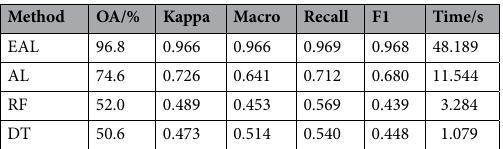
Table 5. Comparison of classification results with the EAL, AL, RF and DT